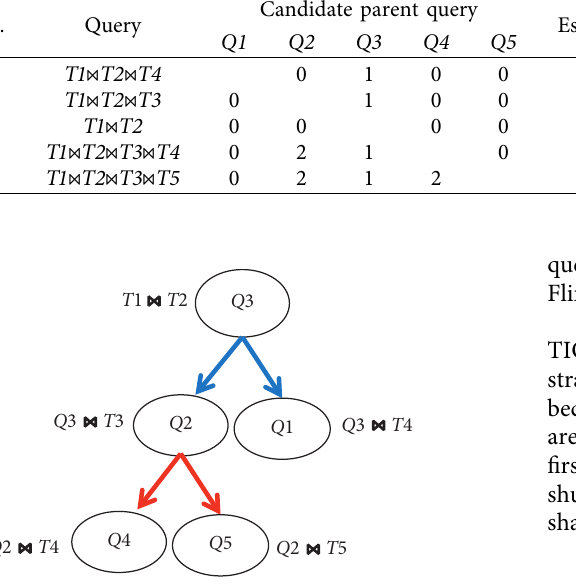
Figure 13: J-MOTH multiway join execution plan using SP